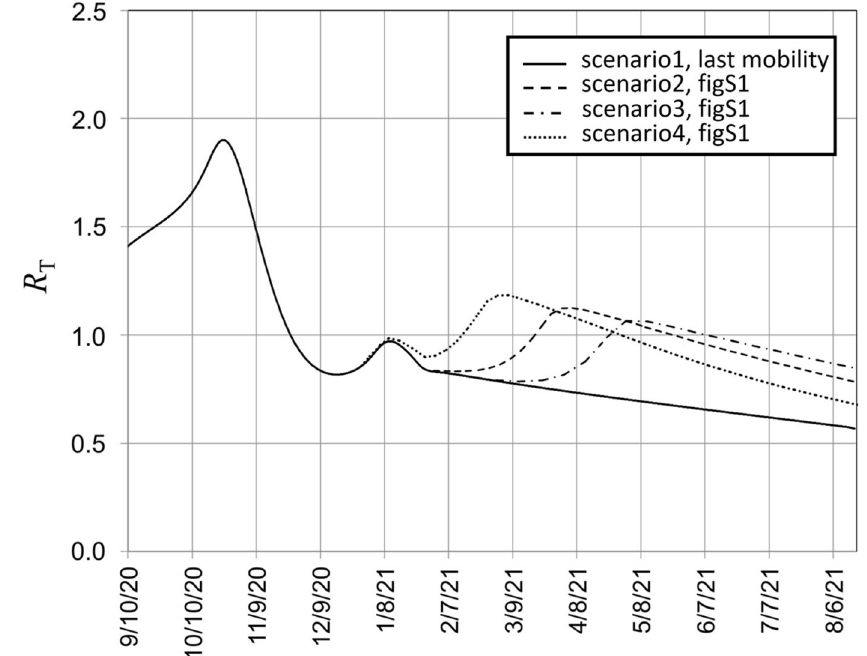
Figure 7. Reproduction number R T as a function of time corresponding to the different scenarios of variation of the diffusion coefficient illustrated in Fig.